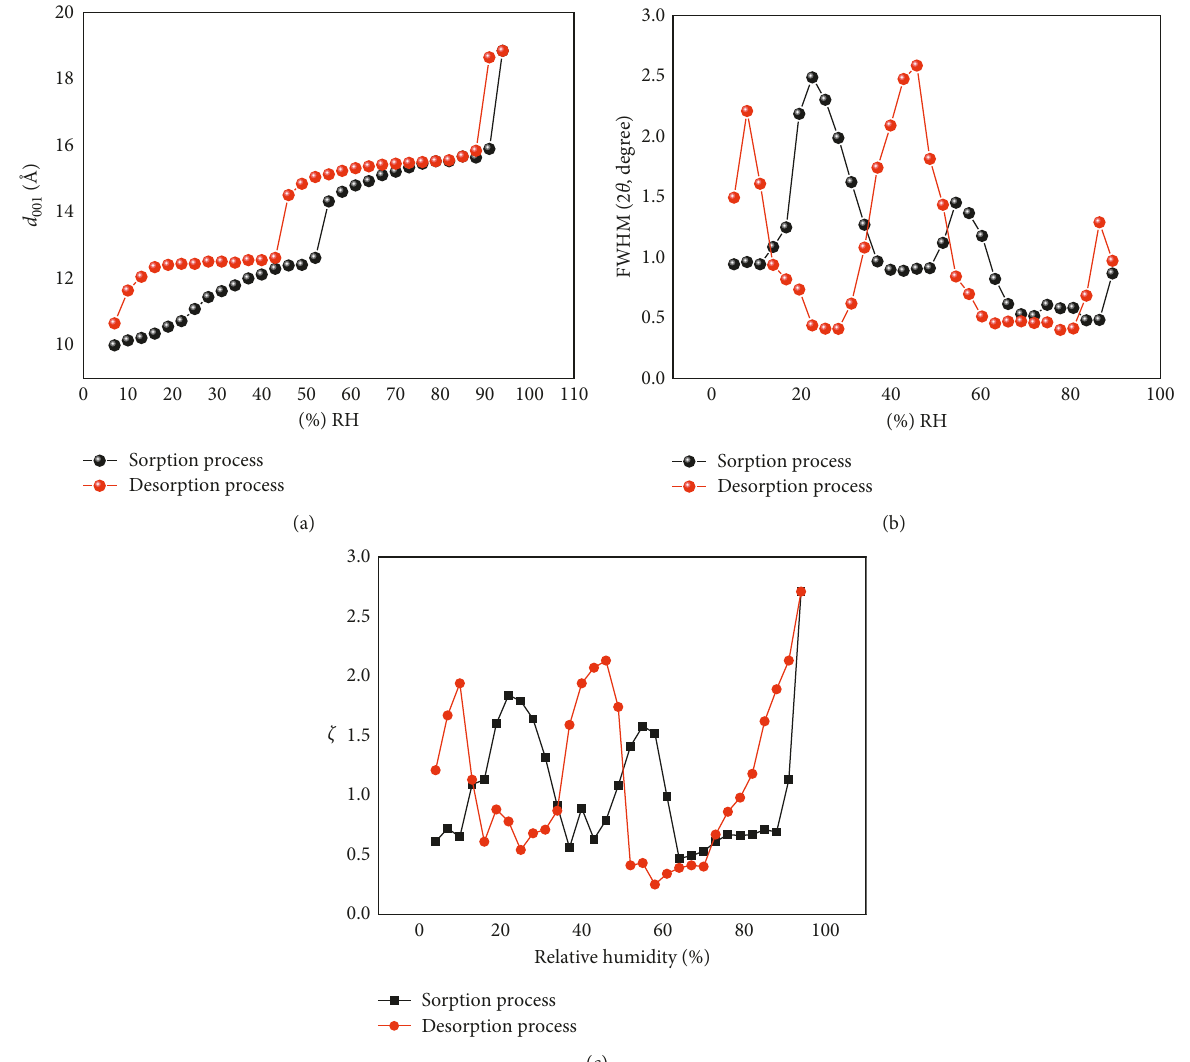
Figure 2: Evolution of the d 001 (a), FWHM (b), and ξ parameters (c) versus %RH in the case of the unstressed sample along the sorption and desorption processes. The ξ parameter, which accounts for the departure from rationality of the 00 l reflection series, is calculated as the standard deviation of the l d 00 l values calculated for the X i measurable reflections ( X i 3 in this case) over the 2 θ Cu-K α angular range × (cid:31) (degree). Blue and yellow circles indicate interstratified hydration character (I) and homogeneous hydration character